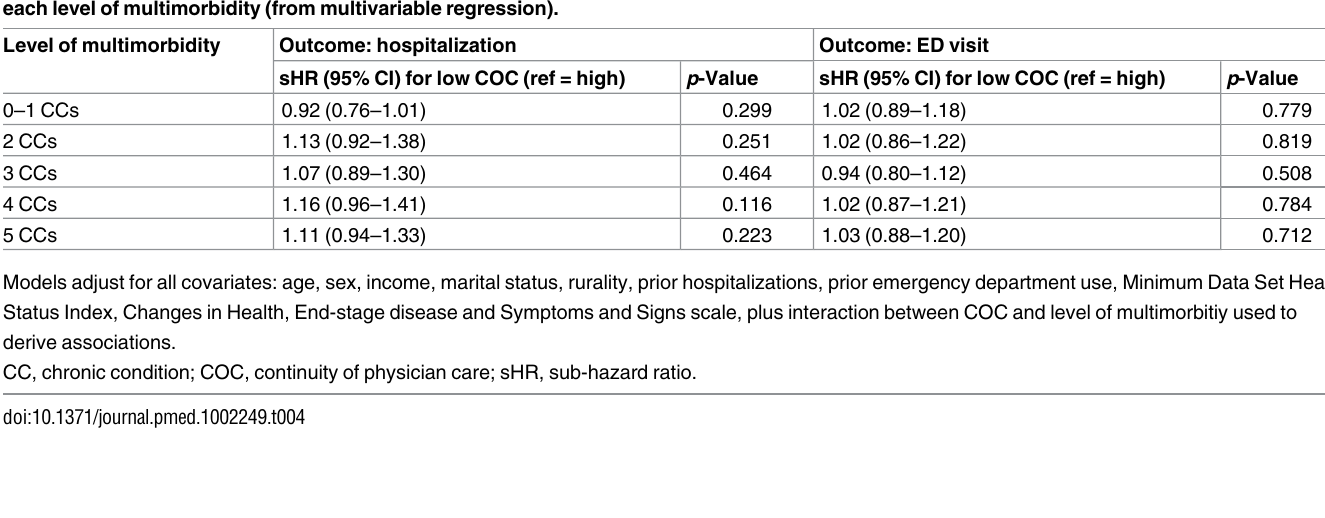
Table 4. Sub-hazard ratios and 95% confidence intervals representing the effect modification of low (versushigh, reference)continuity of care at each level of multimorbidity (from multivariable regression). Level of multimorbidity